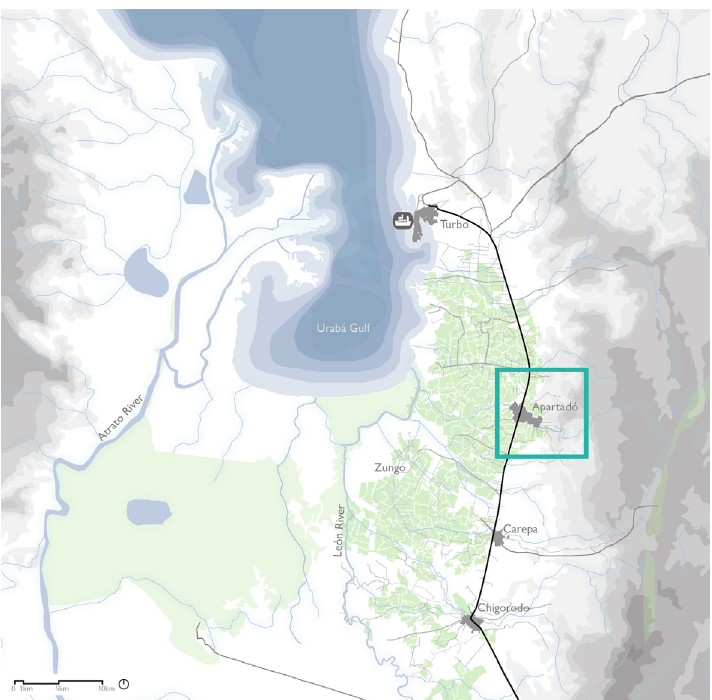
Fig. 9. Location of Apartadó within the region of